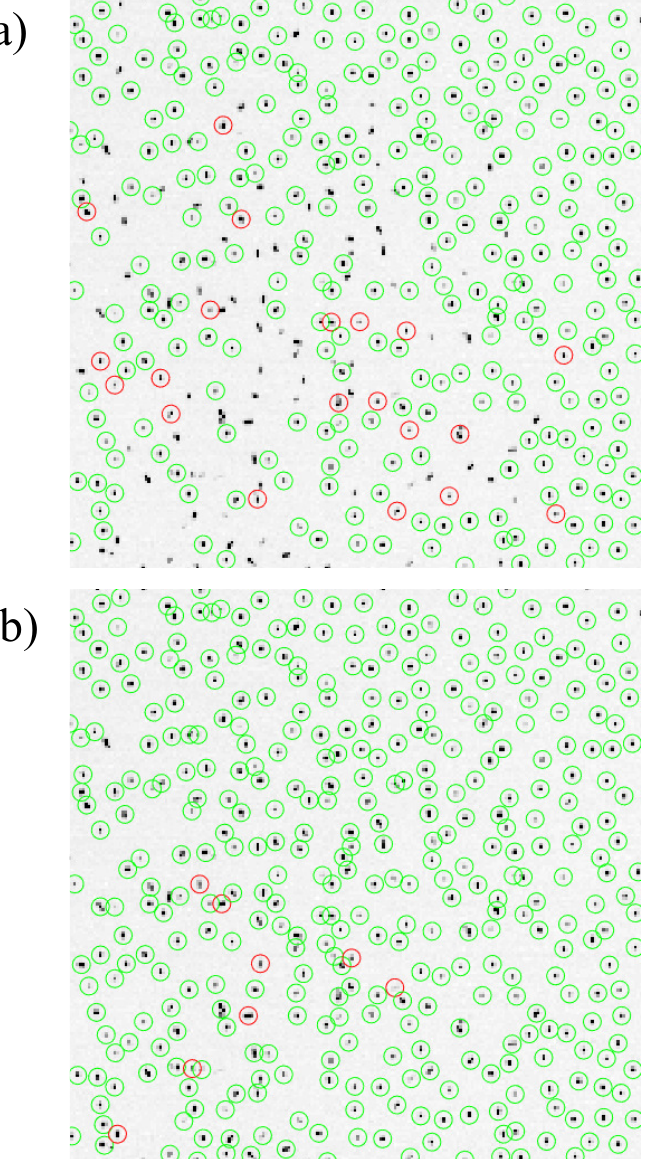
( t ) N + 1 MP ( t ) as starting N + 1 Pred